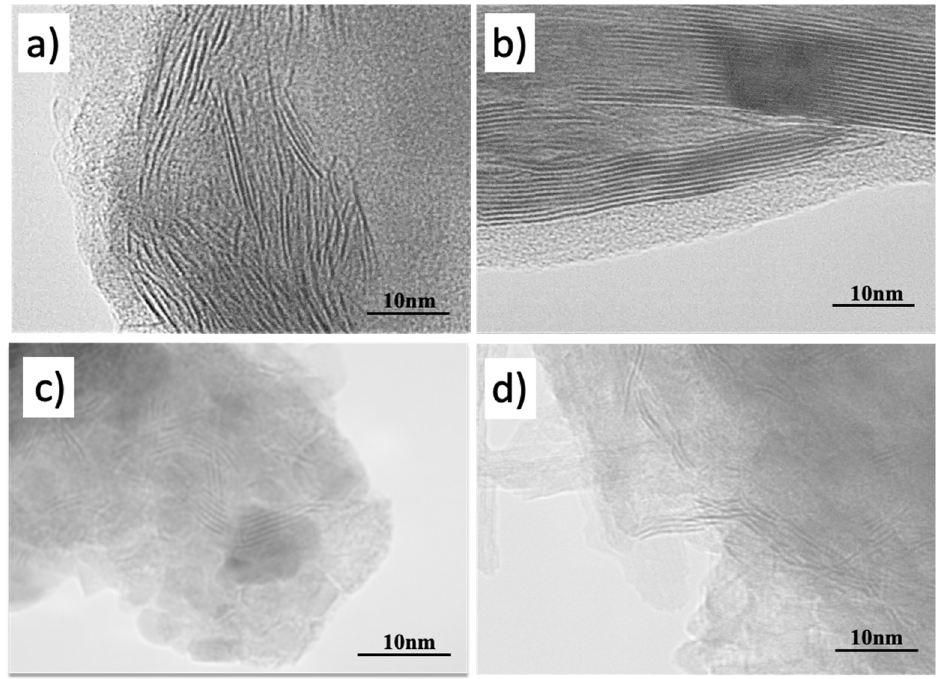
Figure 3. TEM images of KCoMoS 2 /DAS ( a ), KCoMoS 2 /YPK-1 ( b ), KCoMoS 2 /AHM ( c ), and KCoMoS 2 /TCA ( d ).